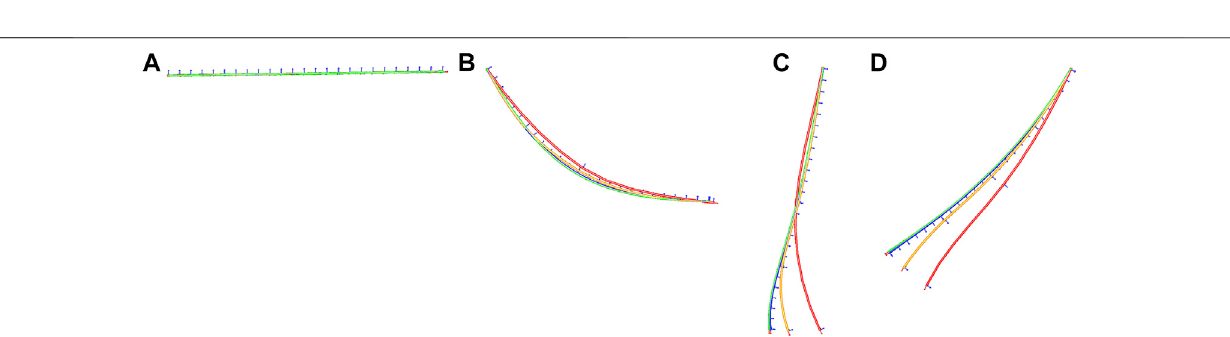
FIGURE 6 | We test four different discretizations of a suture thread of 12 cm subjected to gravity. In increasing order of discretization red — orange — blue — green. The dynamics of the pendular motion is captured at time 0[ s ] (A) , 0.1[ s ] (B) , 0.2[ s ] (C) and 0.3[ s ] (D) . The model converges to a unique solution as the level of discretization